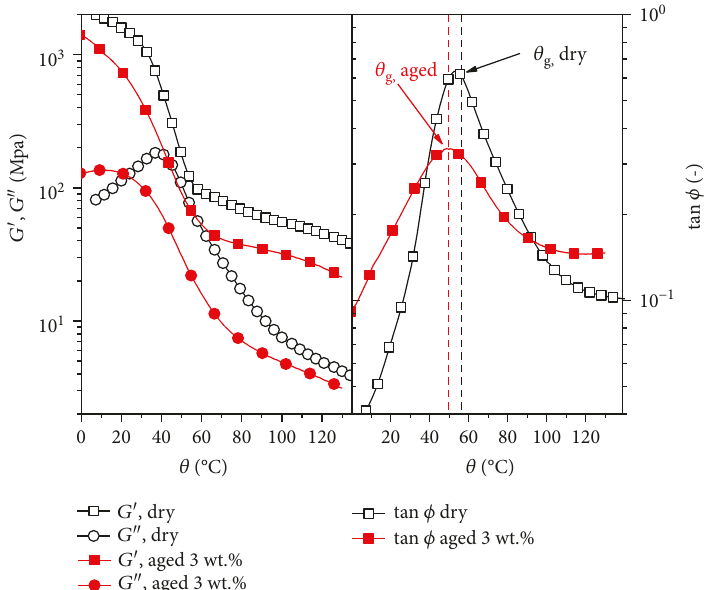
Figure 8: Comparison of the thermomechanical properties of dry (open symbols) and physically (hydrolytically) aged (solid symbols) Estane obtained from DMTA experiments. Left: changes of storage- ( G ′ ) and loss modulus ( G ″ ) for dry (open symbols) and physically (hydrolytically) aged samples (solid symbols) in temperature sweep tests. Right: comparison of loss factor tan ( ϕ ) of dry (open symbols) and (hydrolytically) aged samples (solid symbols) [24].